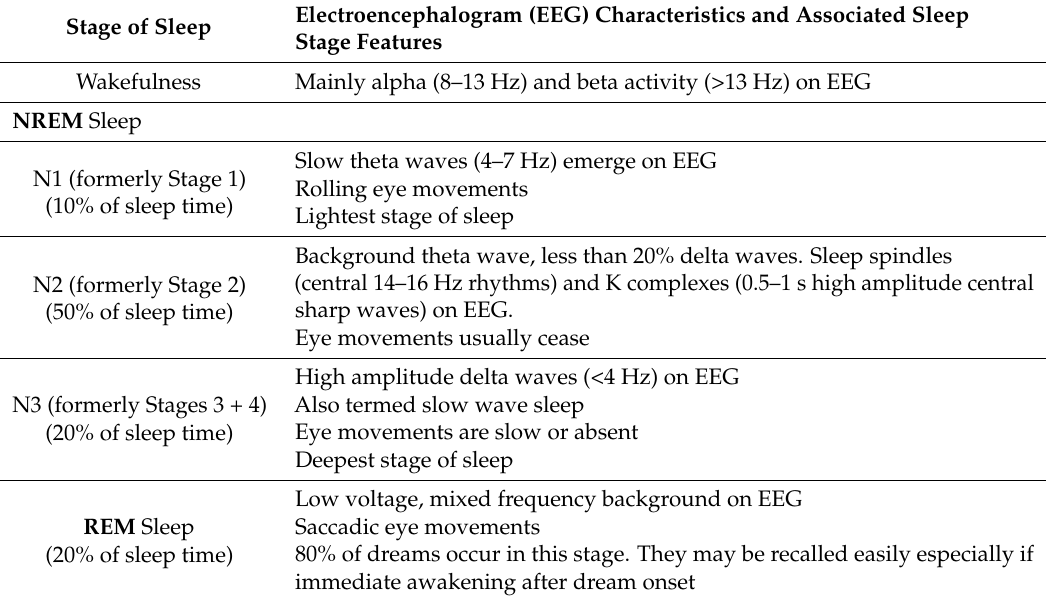
Table 1. Stages of sleep and the associated